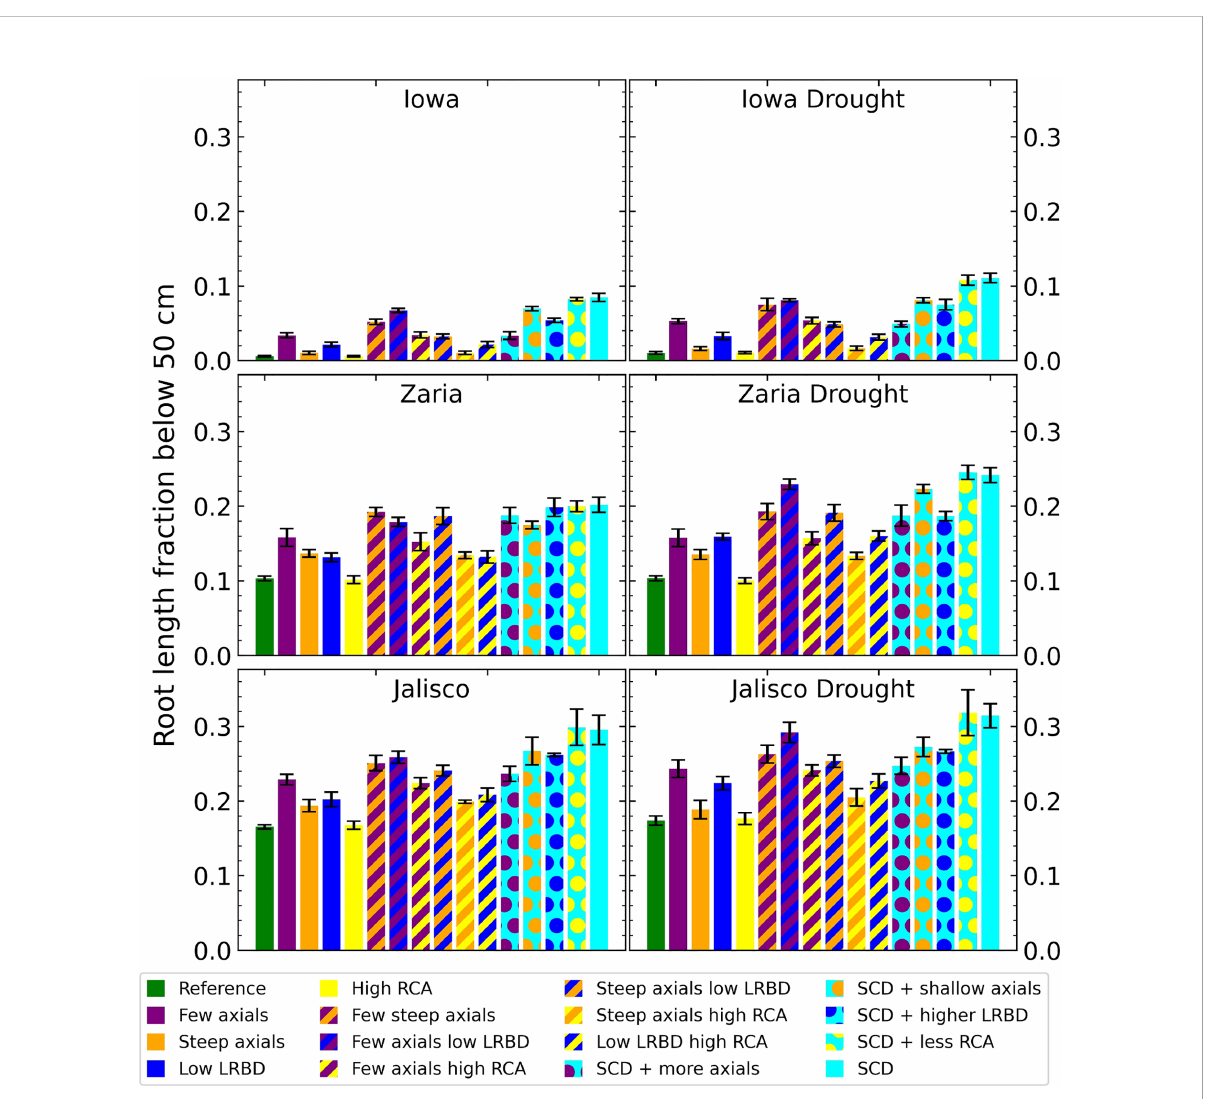
FIGURE 6 Fraction of the total root length below 50 cm deep in the soil of all the maize phenotypes considered after 42 days in the 6 different environments. The error bars indicate standard deviation, n (replicates) = 5. LRBD means lateral root branching density, RCA means root cortical aerenchyma and SCD refers to the steep, cheap, deep